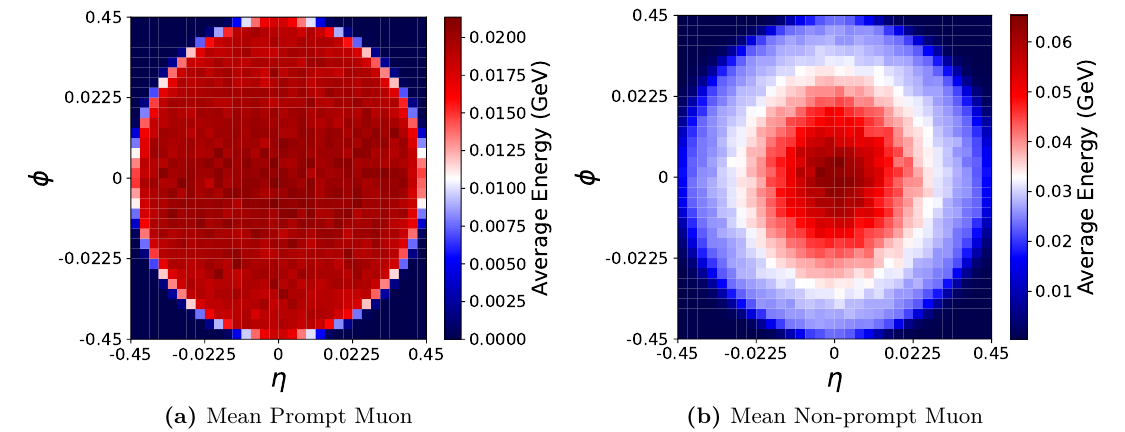
Figure 2. Mean calorimeter images for signal prompt muons (top) and muons produced within heavy-flavor jets (bottom), in the vicinity of reconstructed muons within a cone of R = 0 . 45 . The color of each cell represents the sum of the E T of the calorimeter deposits within the